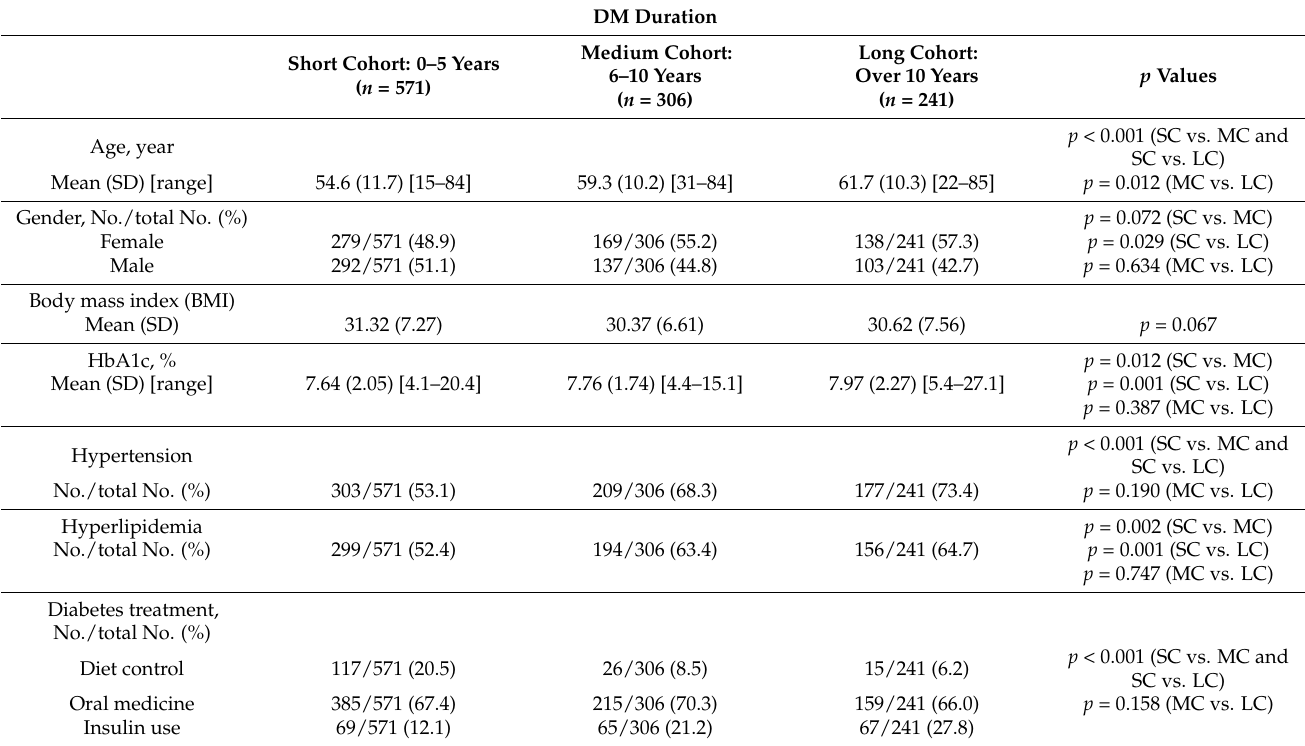
Table 1. Baseline characteristics for patients in the short cohort (DM duration of 0–5 years), medium cohort (DM duration of 6–10 years), and long cohort (DM duration of more than 10